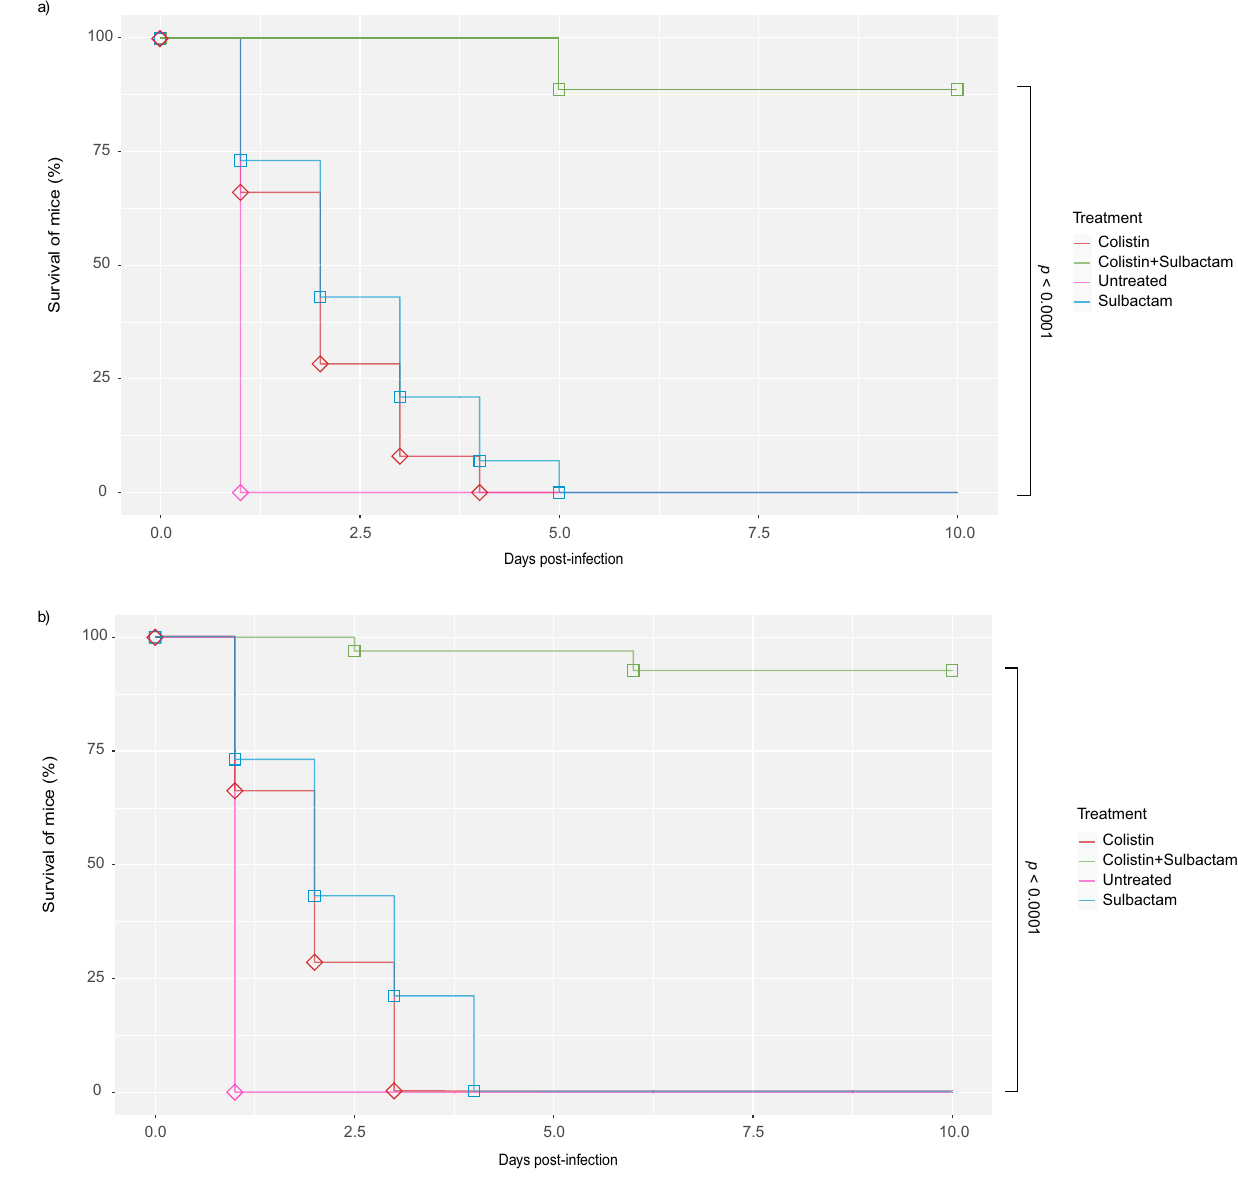
Figure 5. Colistin and sulbactam combination therapy is efficacious in Mouse bacteremia model. Survival curve of representative colistin-resistant A. baumannii isolates ( a ) 1251 and ( b ) 1374 bacteremia infection dosed at 1, 24, 48, 72, 96, and 120 h post infection as outlined above for either colistin (20 mg kg −1 , i.p. n = 10), sulbactam (120 mg kg −1 , p.o. n = 10), untreated (n = 10), or the combination (n = 10). P values were determined using a two-sided, Mann–Whitney